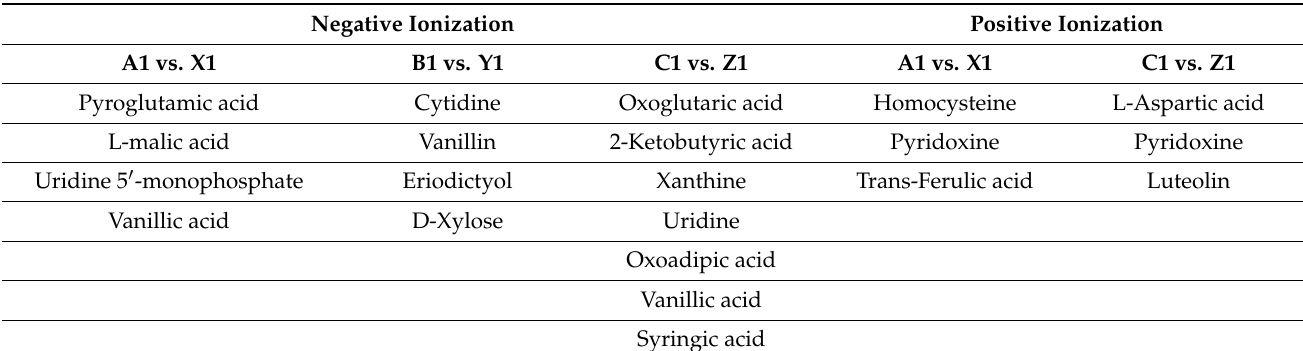
Table 2. Significant metabolites identified in each genotype comparison shared the potential func- tional relationship. These are the enriched metabolites more important in pathways.